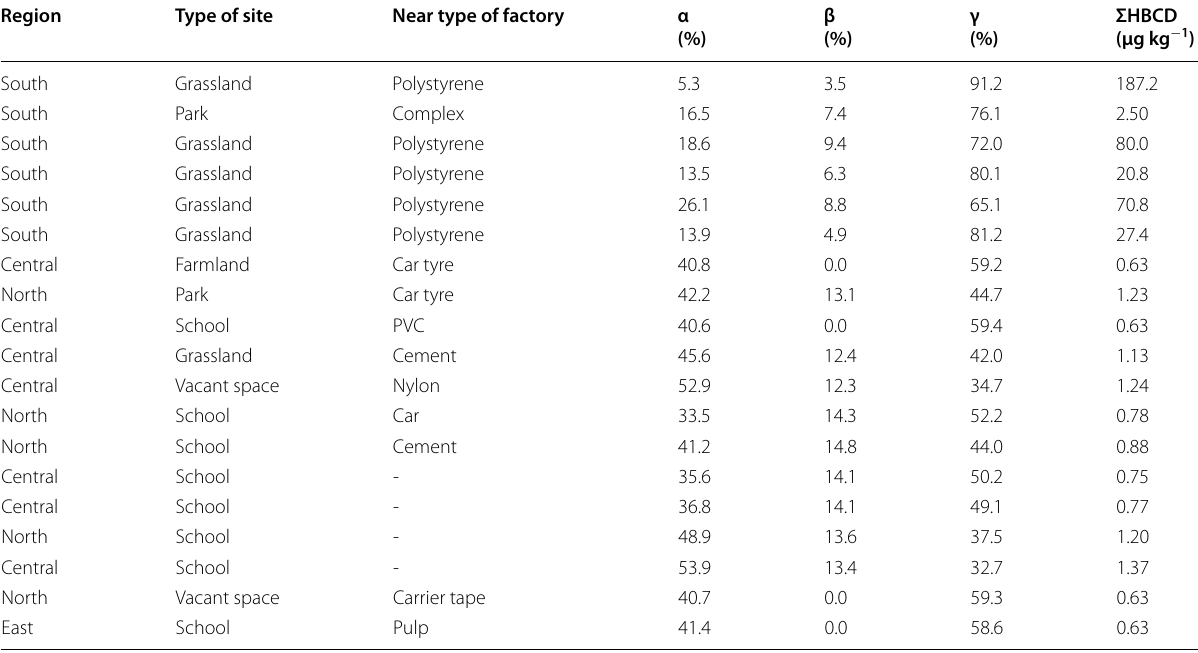
Table 1 Isomer distribution of HBCDs in soil samples Region Type of